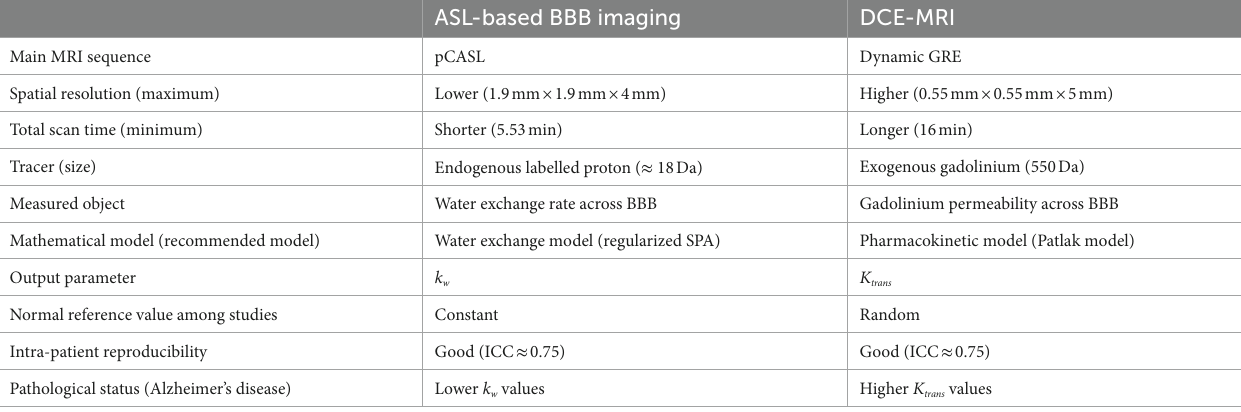
TABLE 1 Comparison between ASL-based BBB imaging and